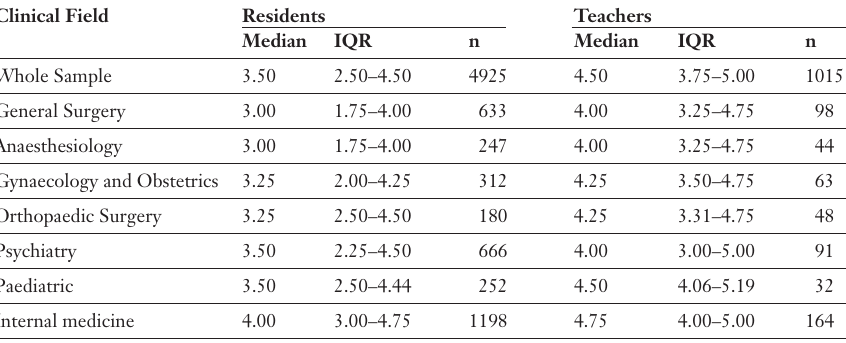
Table 1 Medians and 25 and 75 percentiles (IQR) for the evidence- based medicine scale across seven clinical fields for residents and for